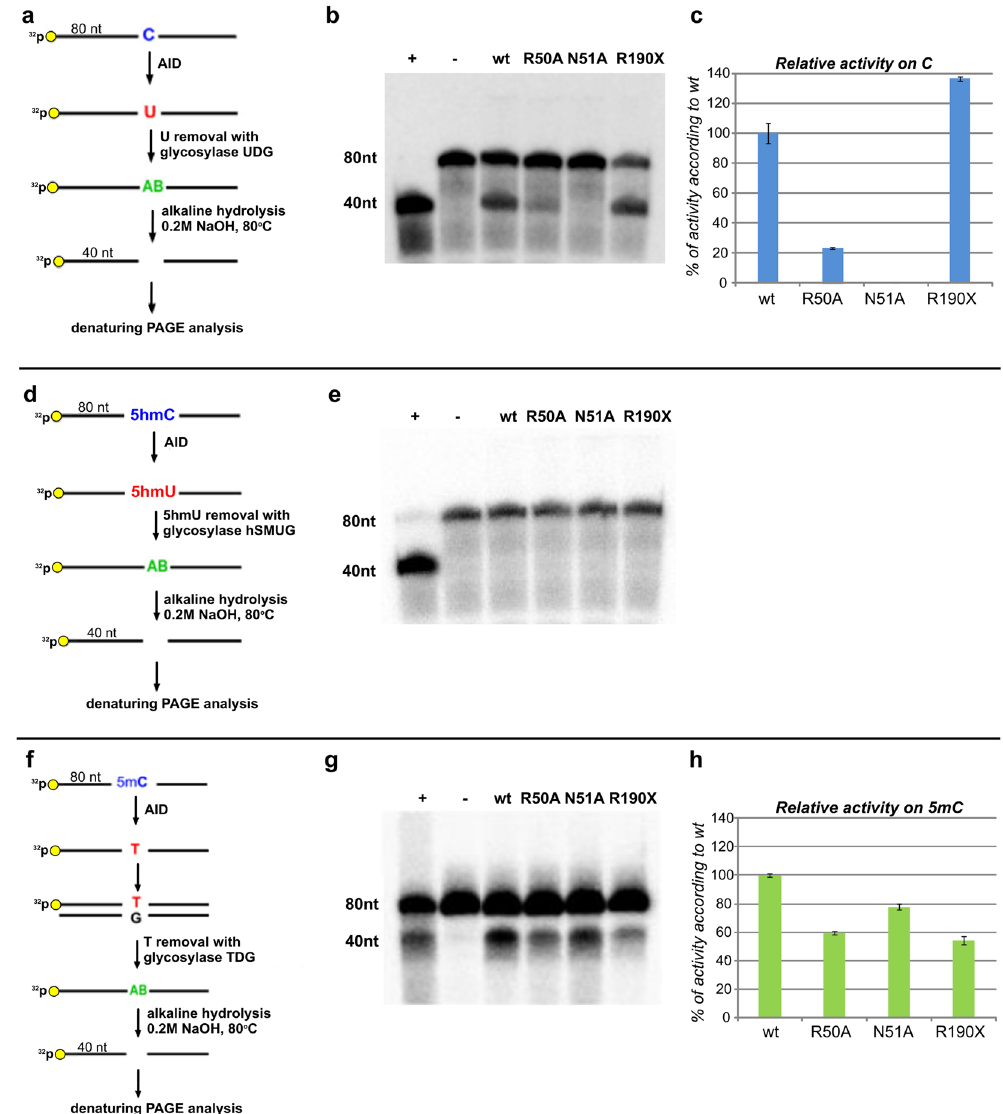
Figure 1. The deaminase activity of the tested hAID variants (wt, R50A, N51A, R190X) on C ( a – c , upper panel), 5 hmC ( d , e , middle panel) and 5 mC ( f – h , bottom panel). ( a , d , f ) Schematic depiction of hAID activity assays applied for the analyses of C, 5 hmC and 5 mC deamination, respectively (see Methods). ( b , e , g ) Denaturing PAGE analysis of the products of deamination of C, 5 hmC and 5 mC, respectively. In the case of deamination, a 40-nucleotide-long product was expected. Positive and negative control reactions are indicated by “ + ” or “ − ”, respectively. The cropped gel images are displayed. Full-length gel images are shown in Supplementary Fig. S6. ( c , h ) Relative deaminase activities of hAID mutants on C or 5 mC. The activities are expressed as a percentage relative to the activity of wt hAID (considered as